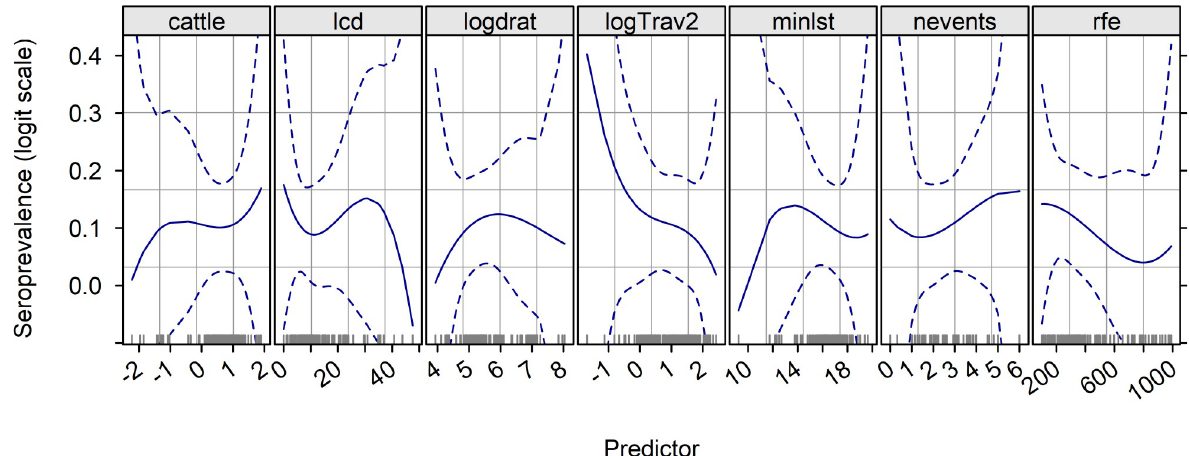
Fig 3. Logit of RVFV seroprevalence (solid line)—and 95% pointwise confidence interval (dashed lines), in small ruminants after the rainy season 2014 in Senegal, according to a spline function of its quantitative predictors. Codes for predictors: ‘cattle‘log of scaled cattle density at sampling locations; ‘lcd‘least-cost distance between the sampling locations and the centroid of the nearest municipality connected with southern Mauritania via incoming ruminant trade; ‘logdrat‘log ratio of small ruminant to cattle densities at sampling locations; ‘logTrav2‘log of travel time needed to cross a one-km pixel at sampling locations; ‘minlst‘minimum night land surface temperature recorded at sampling locations during the rainy season 2014; ‘nevents‘number of dry spells at sampling locations during the rainy season 2014; ‘rfe‘cumulative rainfall at sampling locations in 2014, in